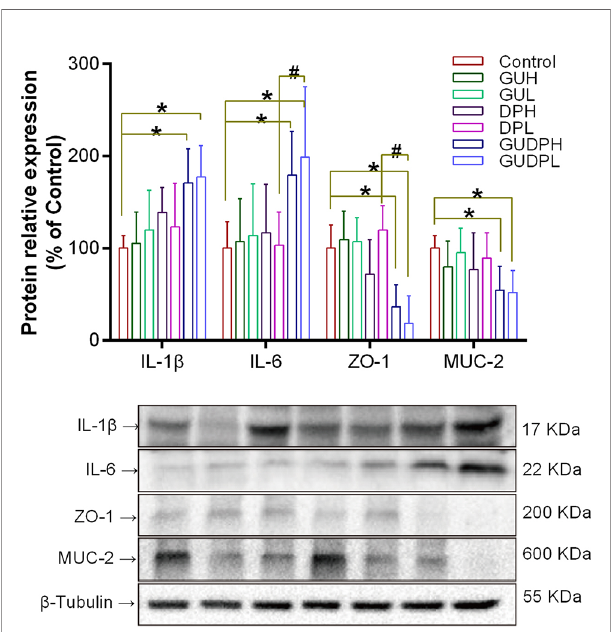
FIGURE 5 | Protein expressions related to in fl ammation and barrier functions in mouse ileum. Upper panel: bar chart of IL-1 b , IL-6, ZO-1, and MUC-2 expressions. Lower panel: blotting images of these proteins with b -tubulin used as internal control. *P < 0.05 compared with control group, # P < 0.05 compared between GUDPH and DPH groups or between GUDPL and DPL groups, as indicated by connecting lines. GUH, licorice high dose; GUL, licorice low dose; DPH, yuanhua high dose; DPL, yuanhua low dose; GUDPH, herbal pair high dose; GUDPL, herbal pair low dose.